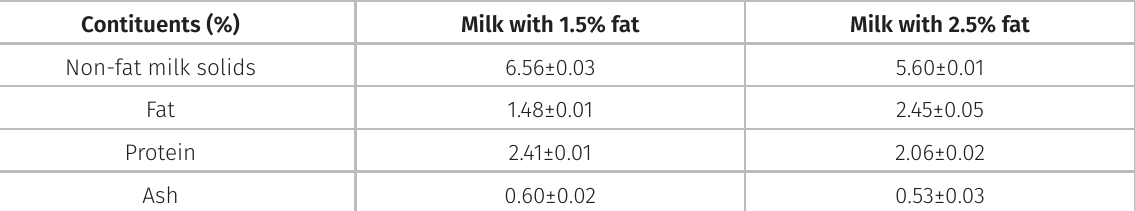
Table I. Composition of standardized milks.